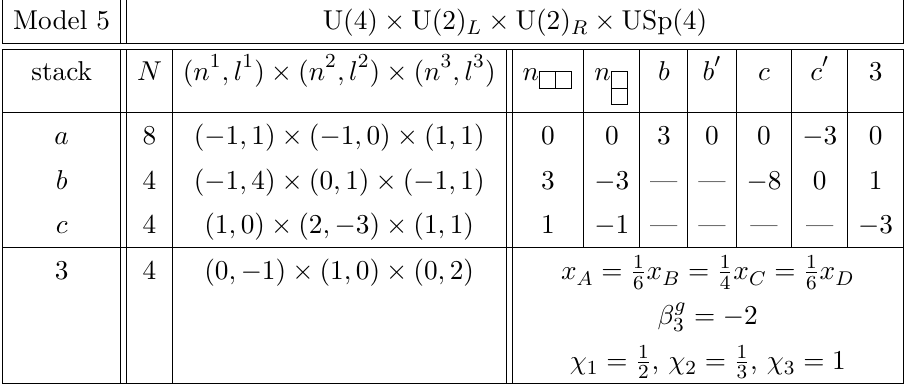
Table 12 . D6-brane configurations and intersection numbers of Model 5, and its MSSM